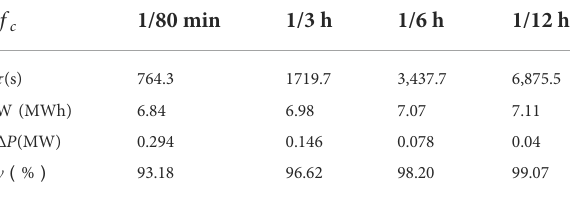
TABLE 4 Calculated results after